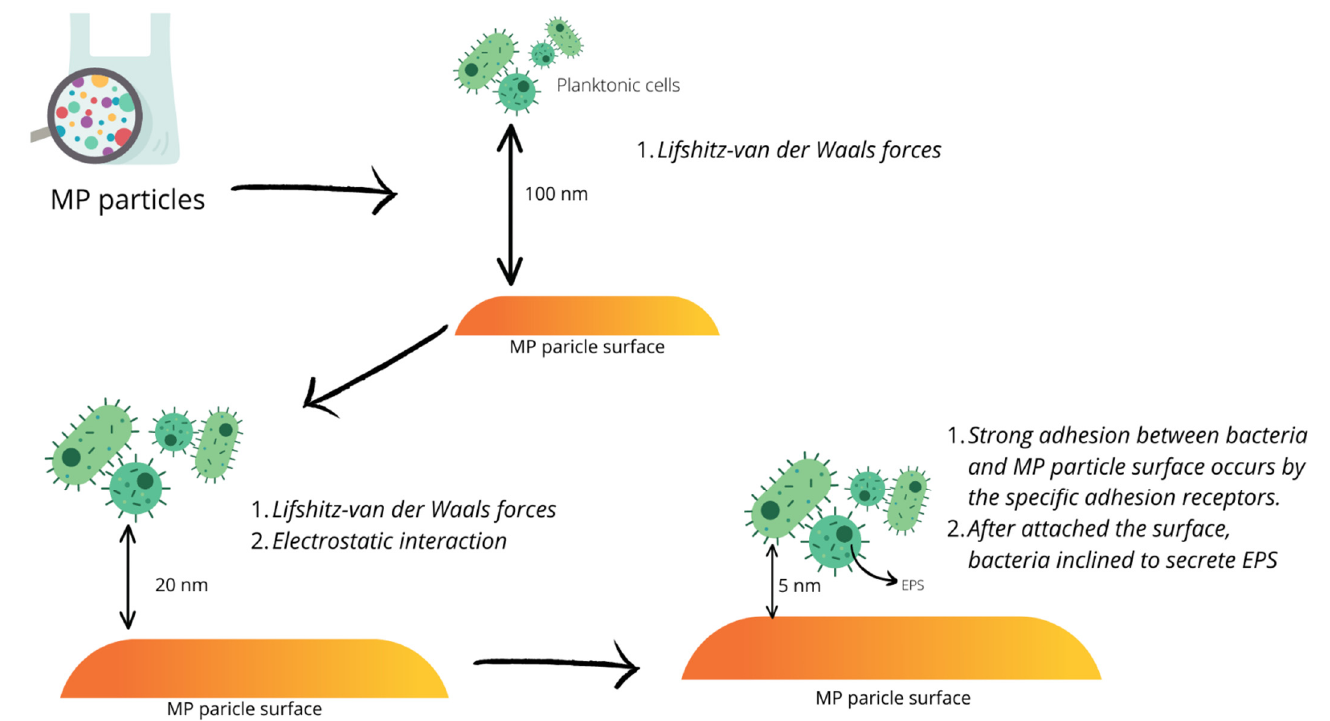
Figure 3. Simplified scheme of bacterial attachment to MPs (based on Wang et al. [74]).